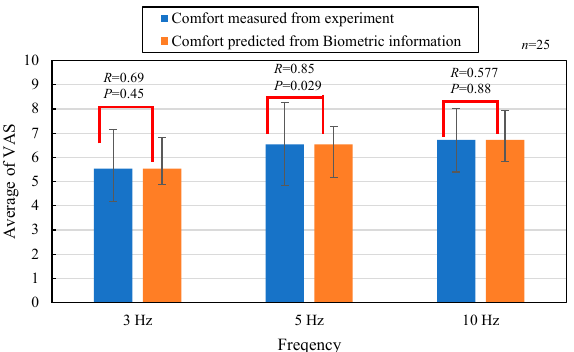
Figure 14. Average and standard deviation of VAS for 25 participants.